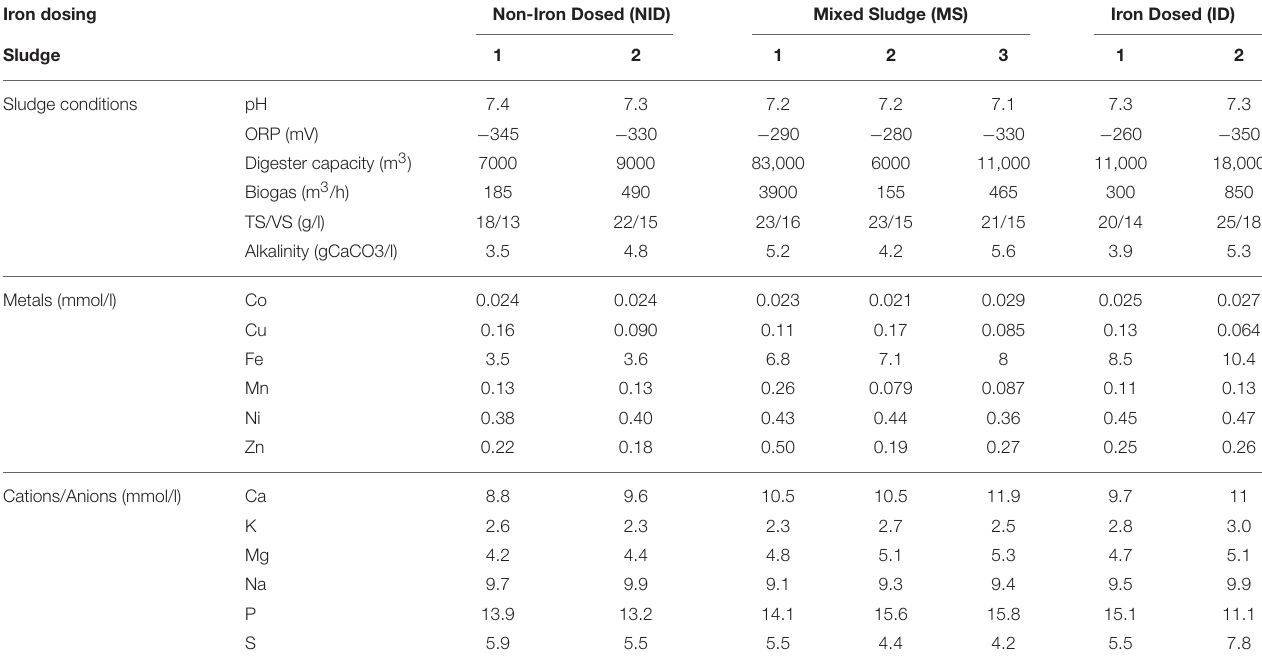
TABLE 1 | Sludge elemental composition and chemical model input values. Iron dosing Sludge Sludge